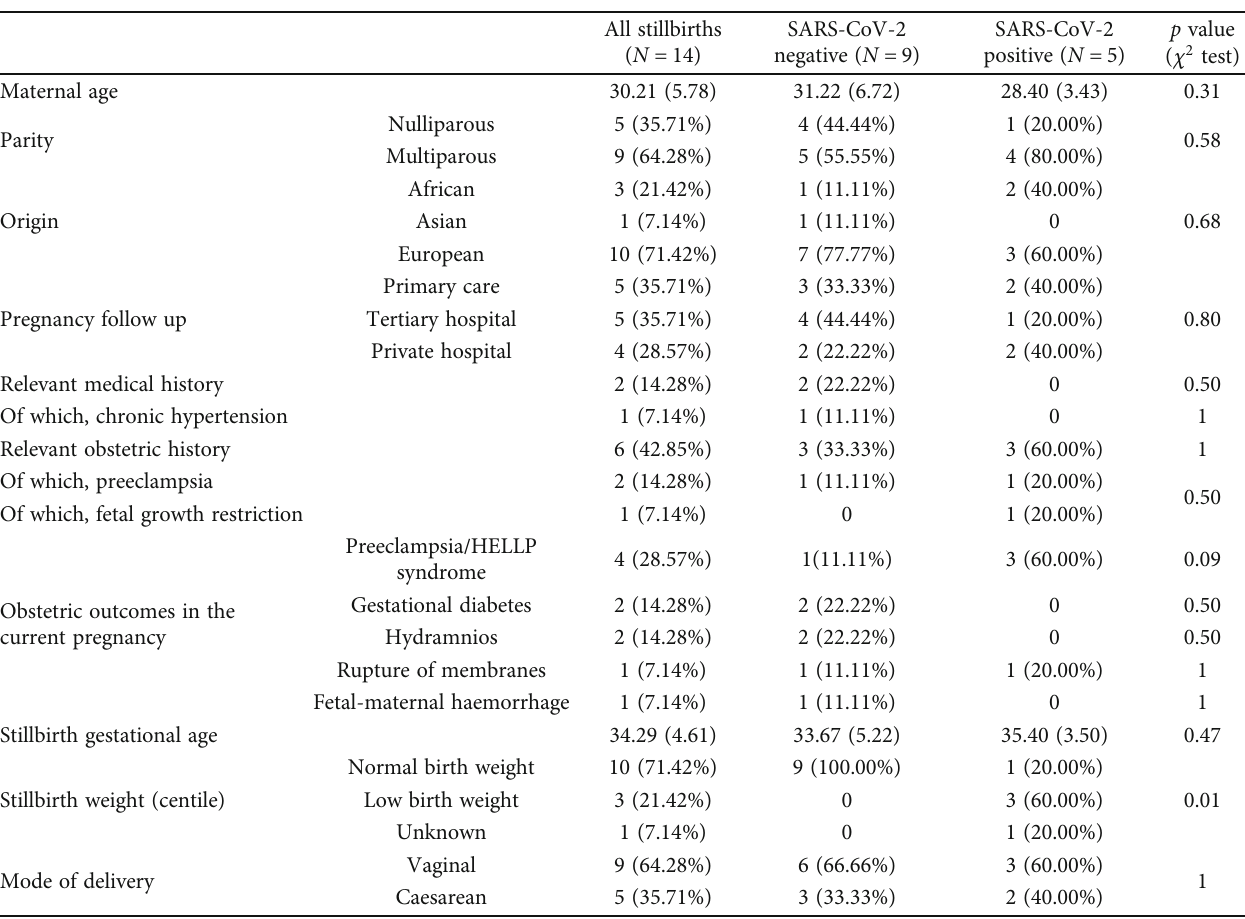
Table 1: Maternal and pregnancy characteristics of stillbirth cases that occurred in a tertiary centre in Portugal between April 2020 and March 2021.